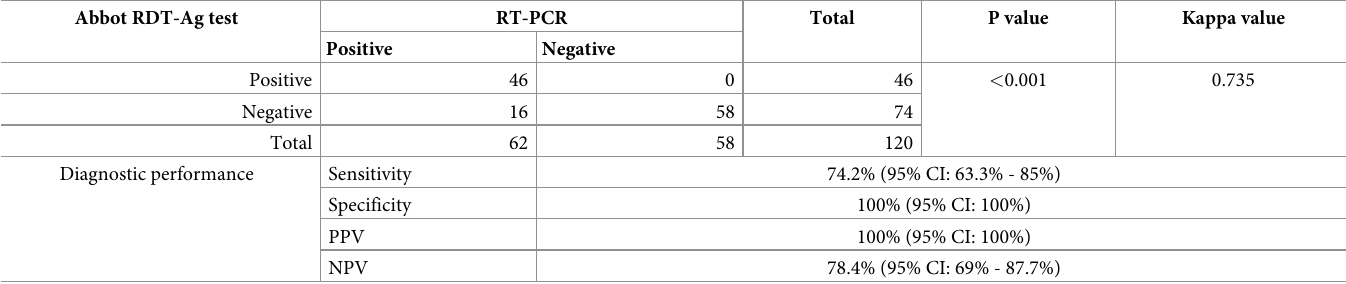
Table 2. Detection rate and diagnostic performance of Abbot RDT Ag test against RT-PCR. Abbot RDT-Ag test